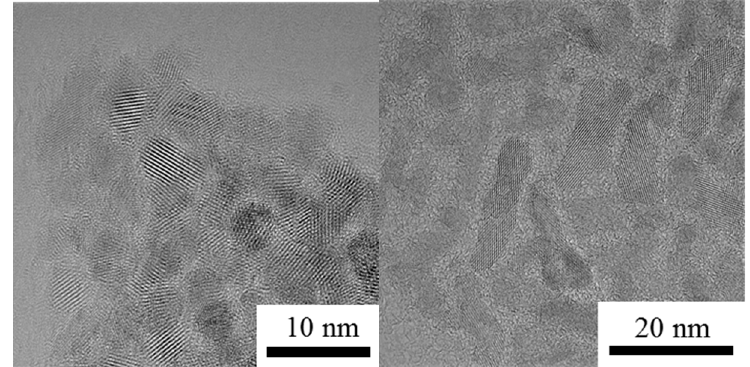
Figure 3. HRTEM (High Resolution Transmission Electron Microscope) images for TiO 2 nanospheres and nanorods.